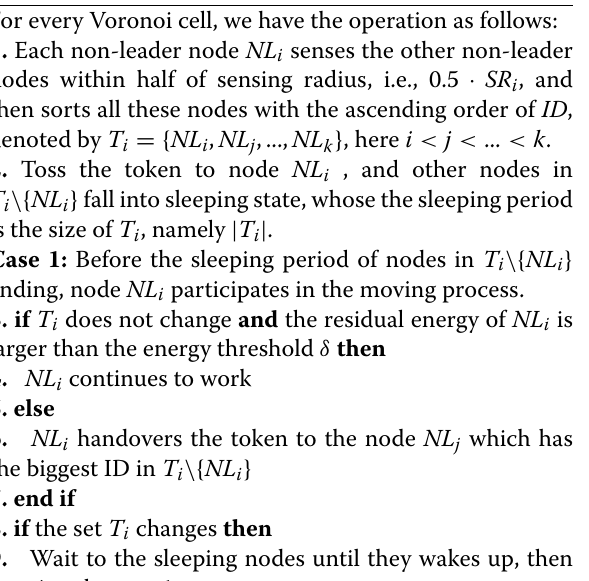
Algorithm 3 Algorithm 3: Periodic sleeping mechanism based Multi-leader election Algorithm